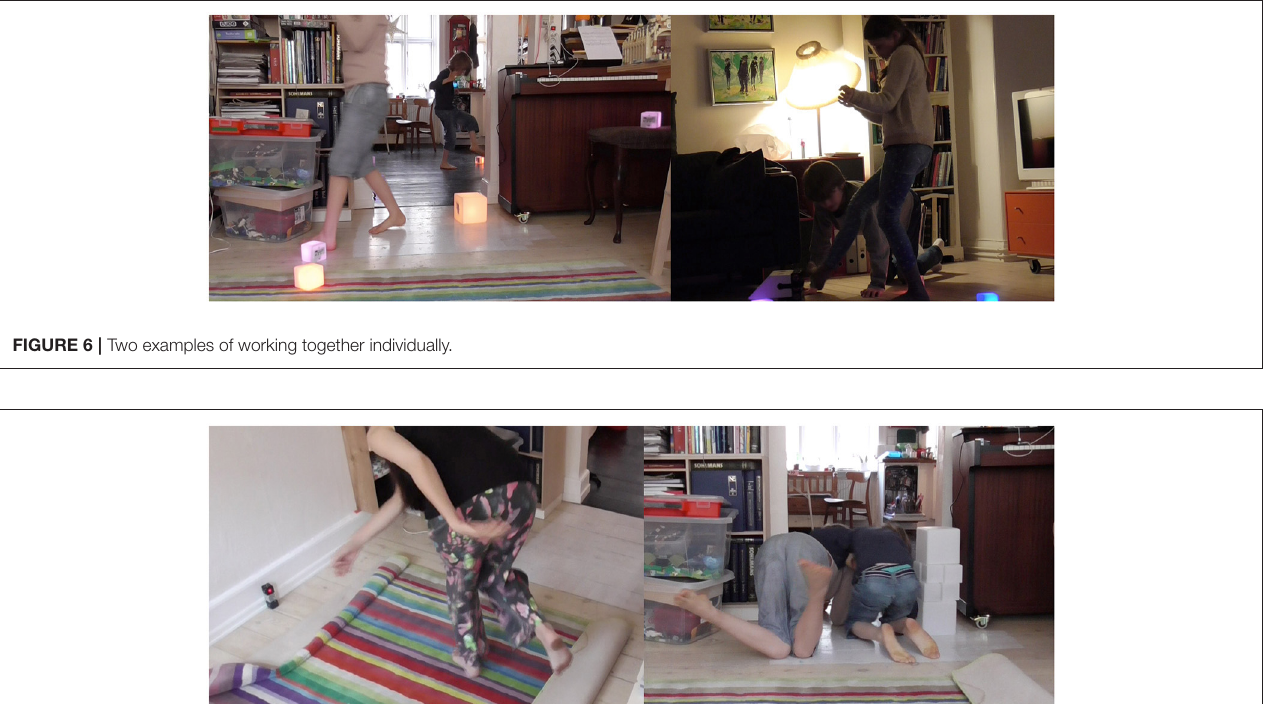
The Game Allowed for Awkward Movements and Silly